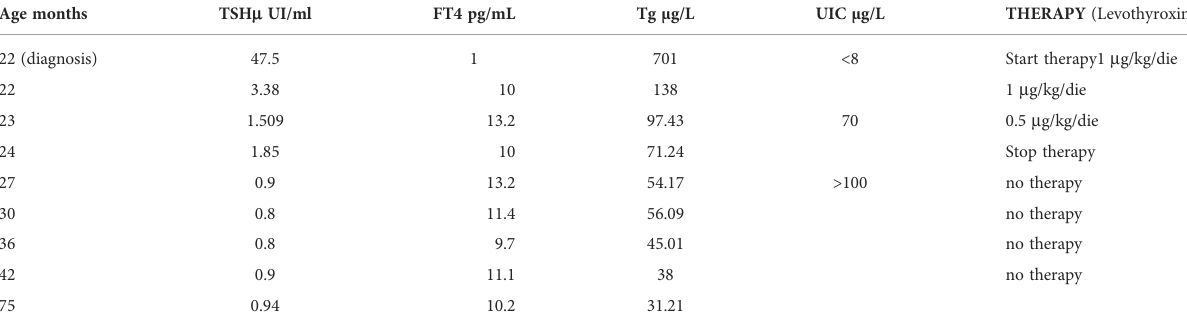
TABLE 1 Laboratory fi ndings during follow-up. Abbreviations: free Thyroxine(fT4), Thyroid. Age months